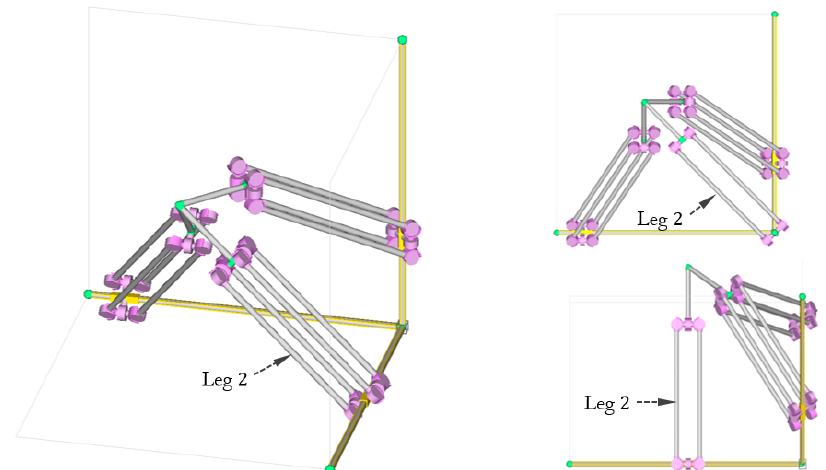
Figure 16. Inverse singular posture.